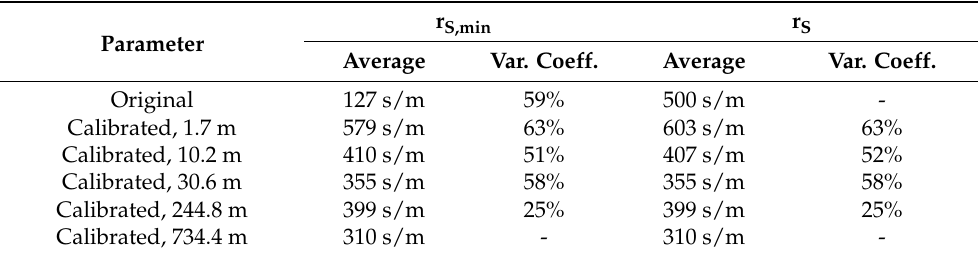
Table 7. Average and variation coefficient for the calibration parameters of the different steps in the scale analysis.